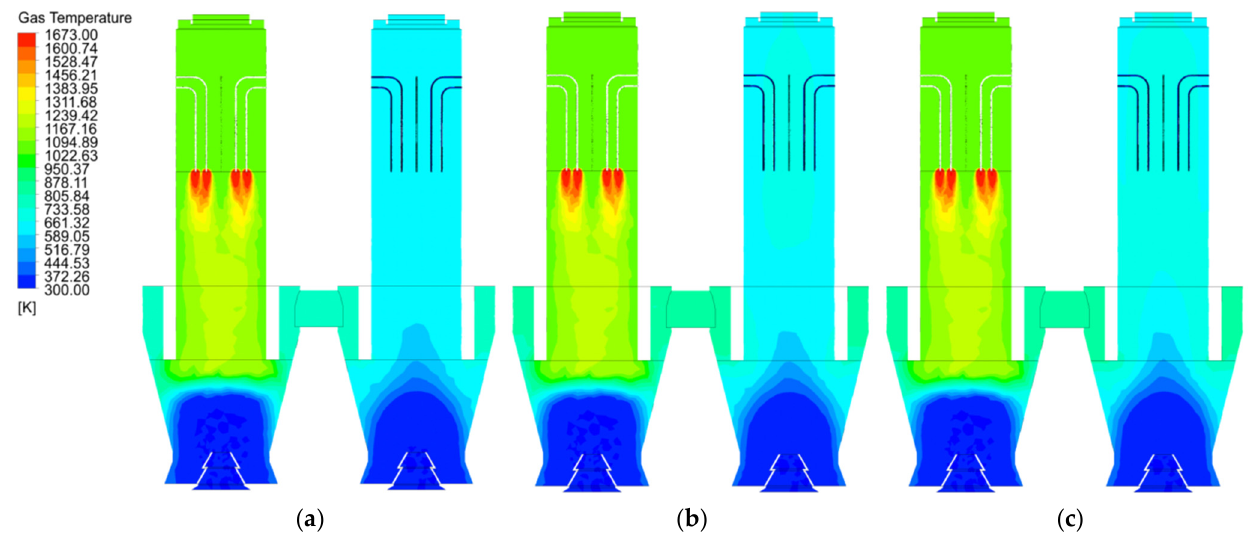
Figure 6. Gas temperature distribution at 40 mm, 80 mm and 120 mm particle sizes. ( a ) Gas temperature distribution at 40 mm ( b ) Gas temperature distribution at 80 mm ( c ) Gas temperature distribution at 120 mm.